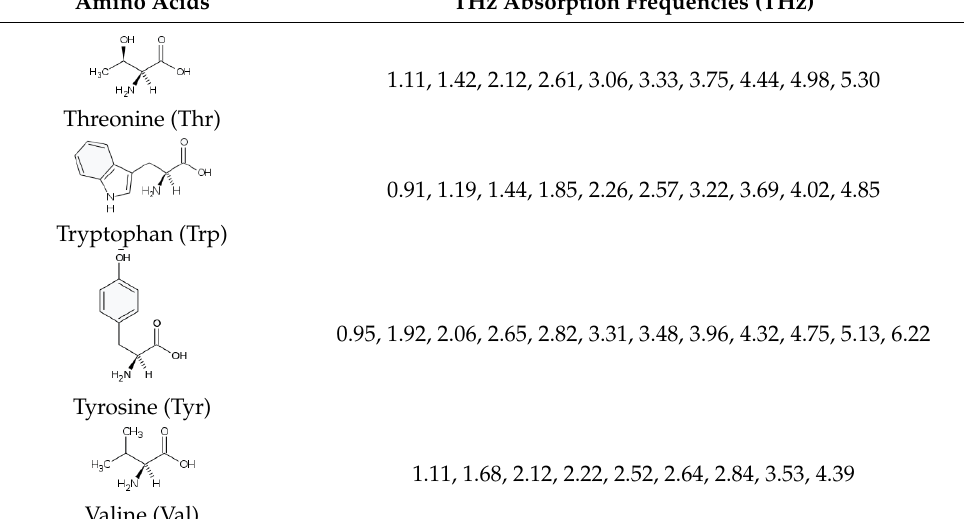
Table 1. Cont. Amino